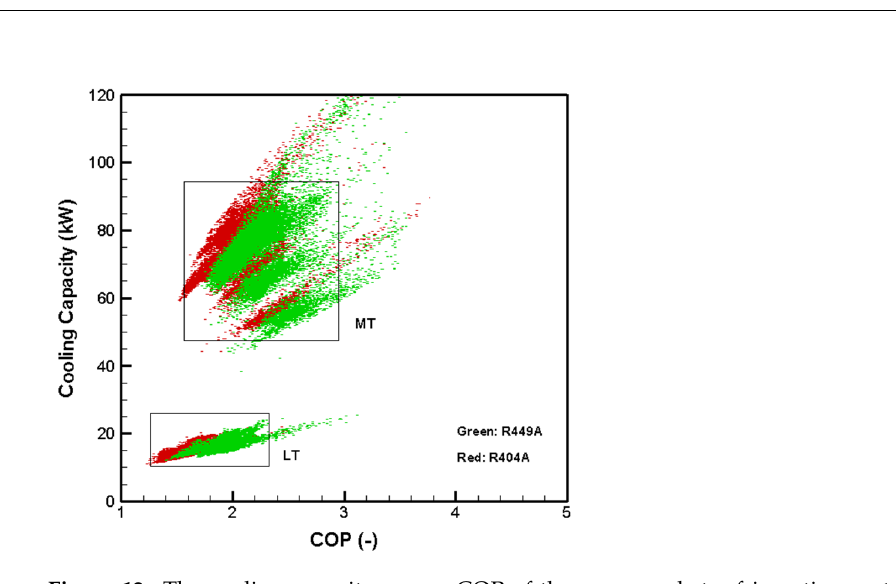
Figure 12. The cooling capacity versus COP of the supermarket refrigeration system at LT and MT applications.